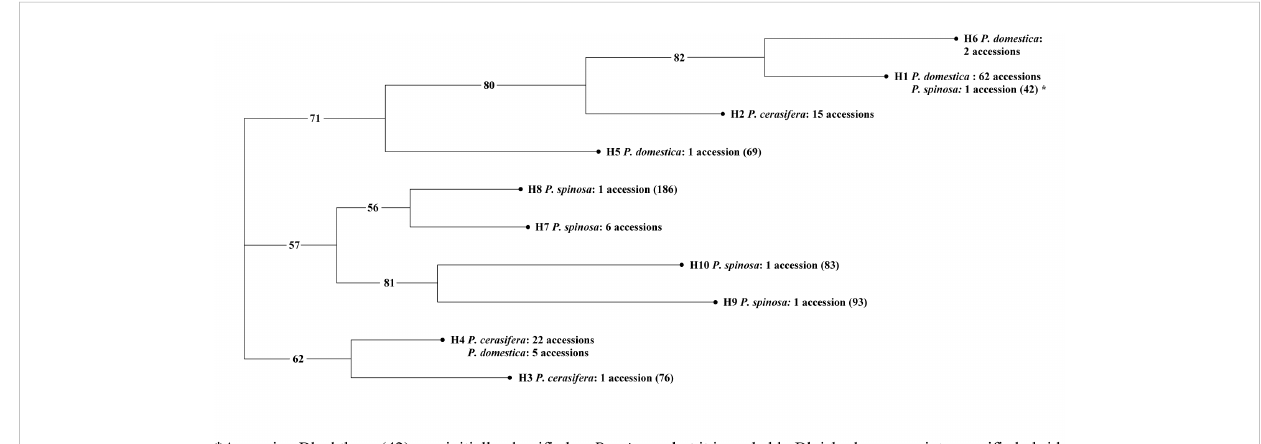
FIGURE 1 Neighbor-Joining tree based on cpDNA marker data for the three plum species ( P. cerasifera , P. domestica , and P. spinosa ). The complete list of studied accessions with the corresponding haplotypes and their codes can be found in Table